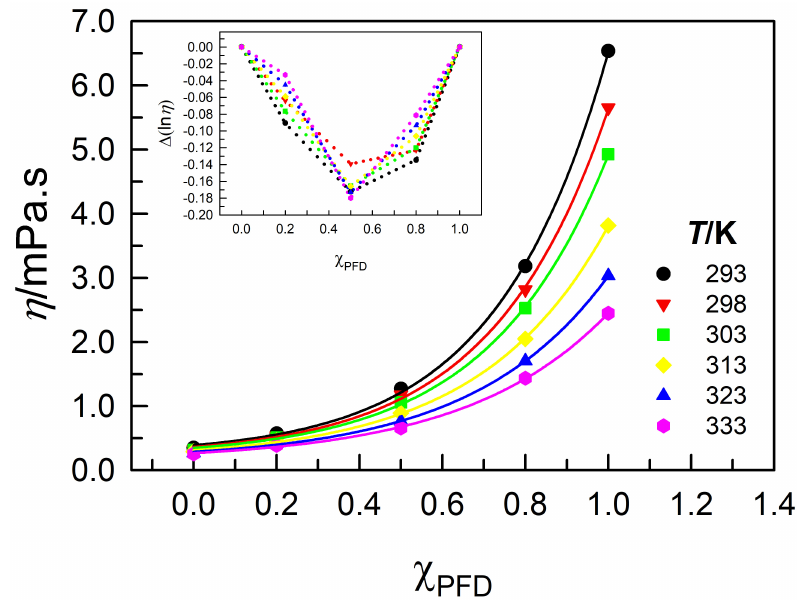
(6) Table 5. Summary of parameters associated with dynamic viscosity of the investigated mixtures